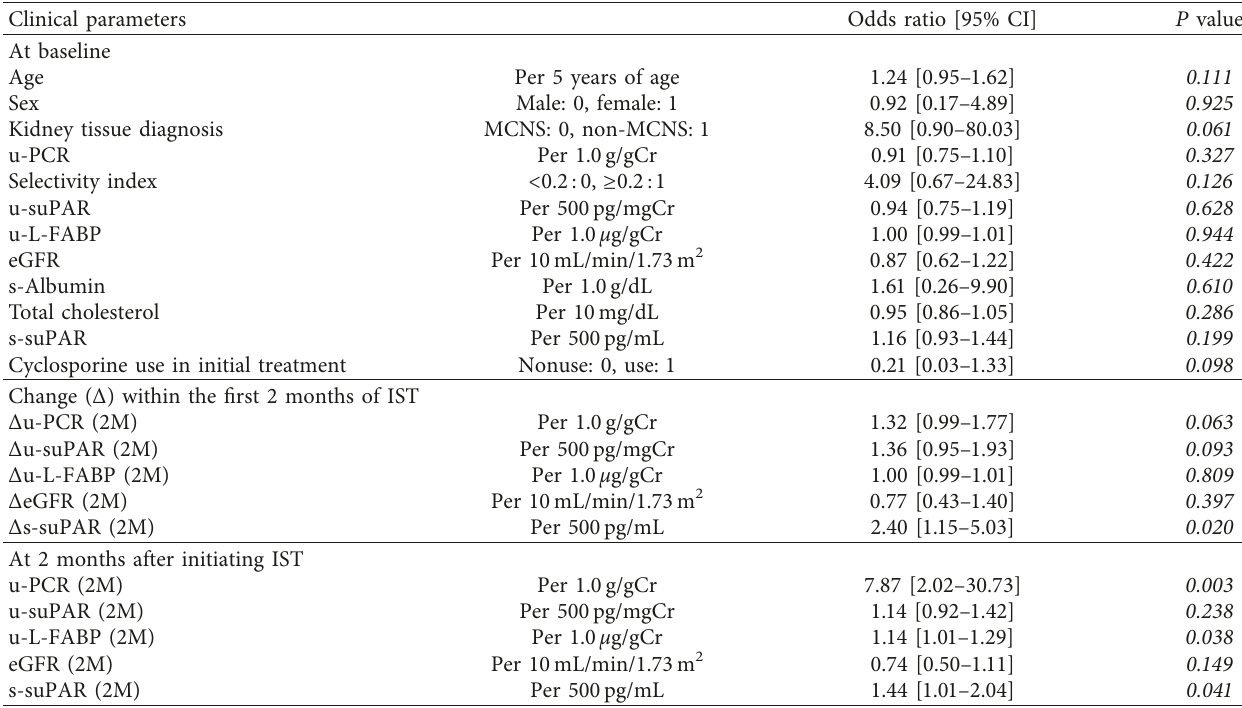
Table 4: Univariate logistic regression analysis of predictive factors for intractable NS.